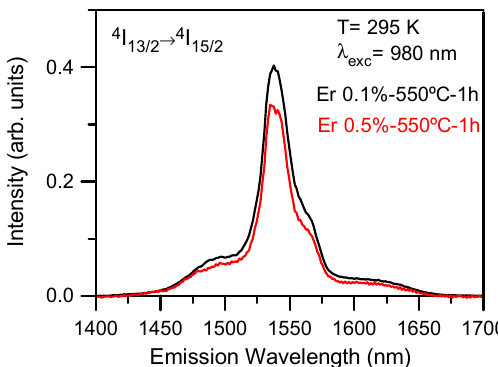
Figure 13. Room temperature emission spectrum of 80SiO 2 -20LaF 3 (TEOS-MTES) thin films doped with 0.1% (black line) and 0.5% (red line) Er 3+ heat treated at 550 ° C for 1 h obtained on exciting at 980 nm.